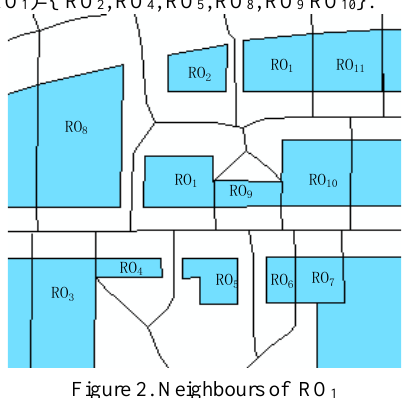
Figure 2. Neighbours of RO 1 Definition 4. Near boundary of RO: The near boundary of RO refers to the region of a site insert into and neighbours to RO. The Delaunay triangulation is the “dual” of the Voronoi diagram. and RO 7 are equal. Drawing the circles center on vertices of region of RO 1 (i.e., V 1 , V 2 , V 3 , V 4 , V 5 ). The nearboudary of RO 1 not only consists of circle arcs but also the segments of its neighbours. The gray-dash line is the circles and the red solid region is the near boundary of RO 1 .